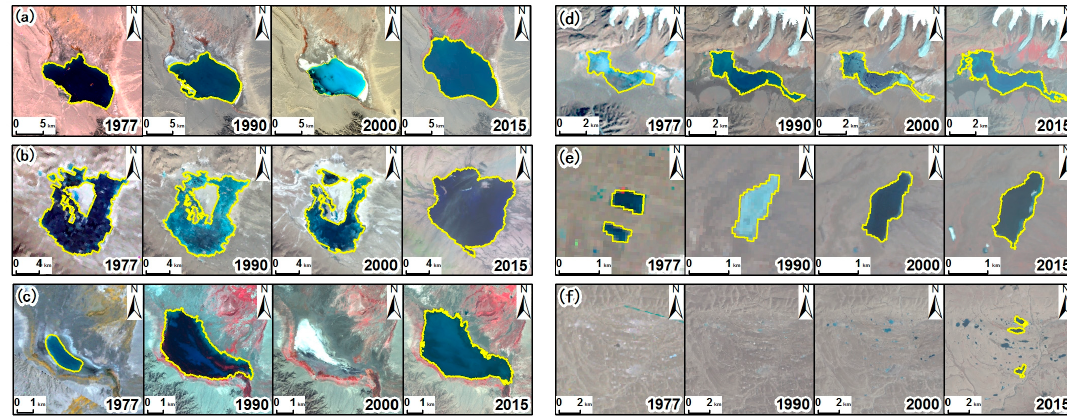
Figure 10. Evolution of typical lakes as shown in Landsat images: ( a – c ) represent the typical lakes significantly influenced by precipitation; ( d – f ) represent the expanding of glacier-fed lakes.